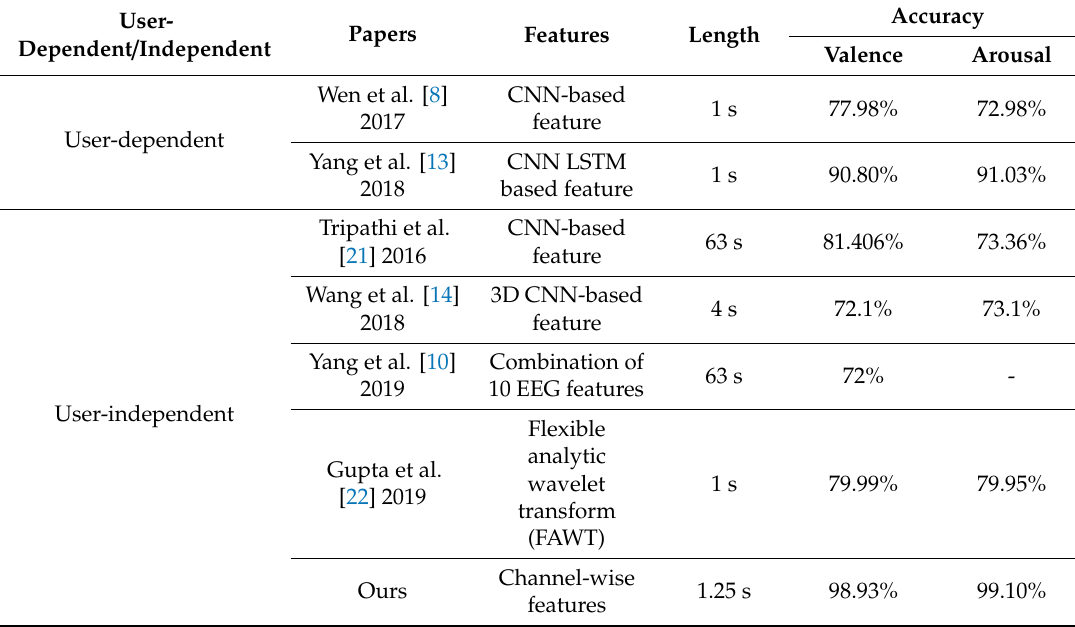
Table 2. Comparison between classification accuracy rates of our models and previous studies for two-class (high, low) valence and arousal classification of the DEAP.